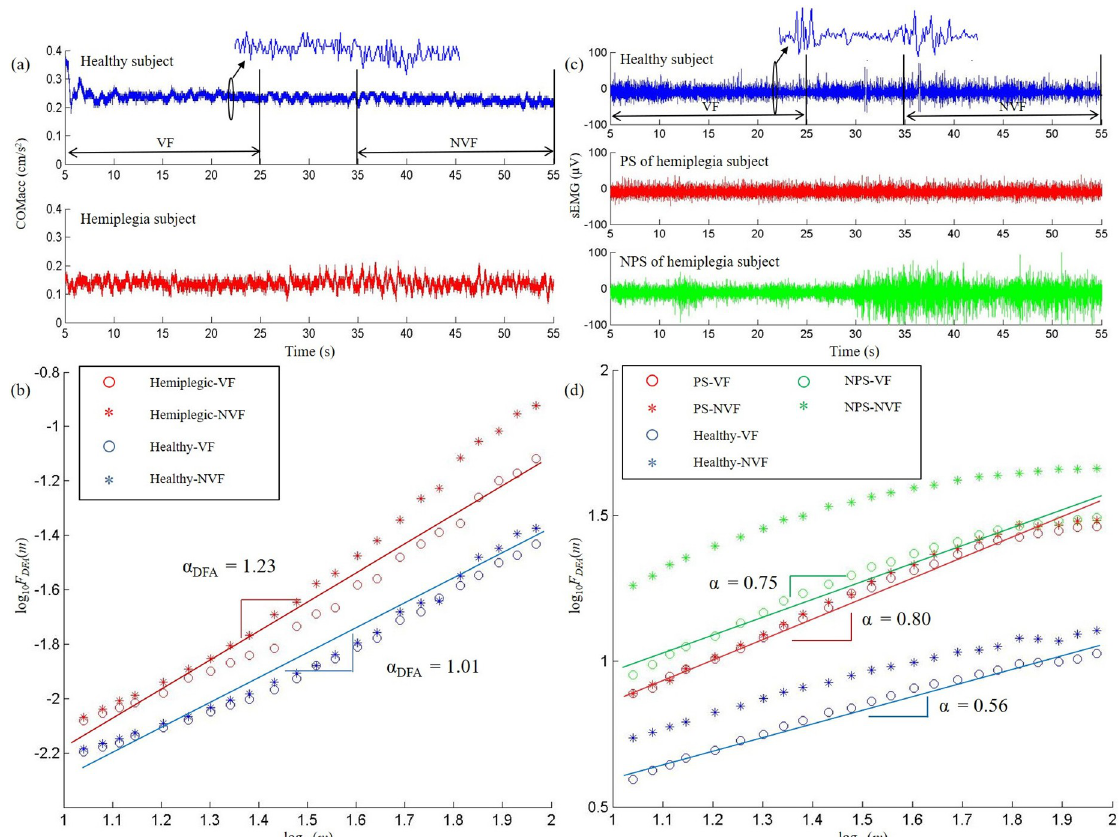
Fig 4. Representative signals and their scaling exponent calculated using the EMD-DFA. (a) The center of mass acceleration (COM acc ) in anteroposterior (AP) direction from a representative hemiplegic subject and a healthy subject, (b) the EMD-DFA scaling exponents of the COM acc shown in (a) on a log-log plot; (c) the sEMG signals of lateral gastrocnemius (LG) from a representative hemiplegic subject and a healthy subject, (d) the EMD-DFA scaling exponents of the sEMG of LG shown in (c) on a log-log